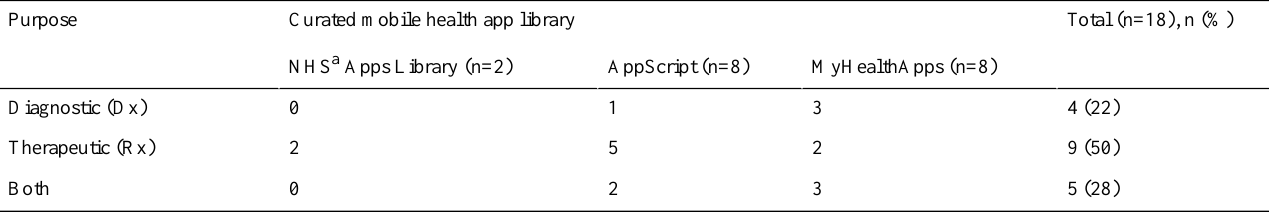
Table 3. Purpose for mobile health apps identified using built-in mobile phone